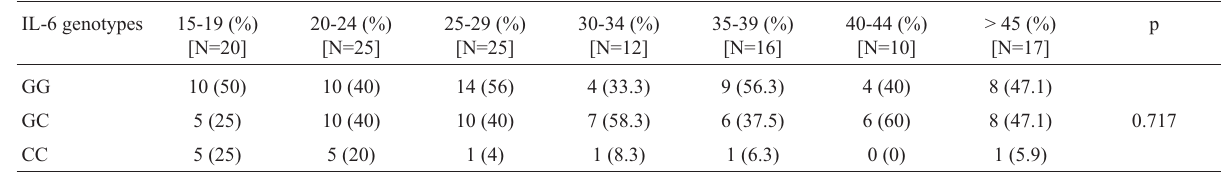
Table 3 - Distribution of IL-6 –174 G/C (SNP rs1800795) genotypes in relation to age group (years old). The results are expressed as a percentage (%) in relation to the total sample size of each group. IL-6 genotypes